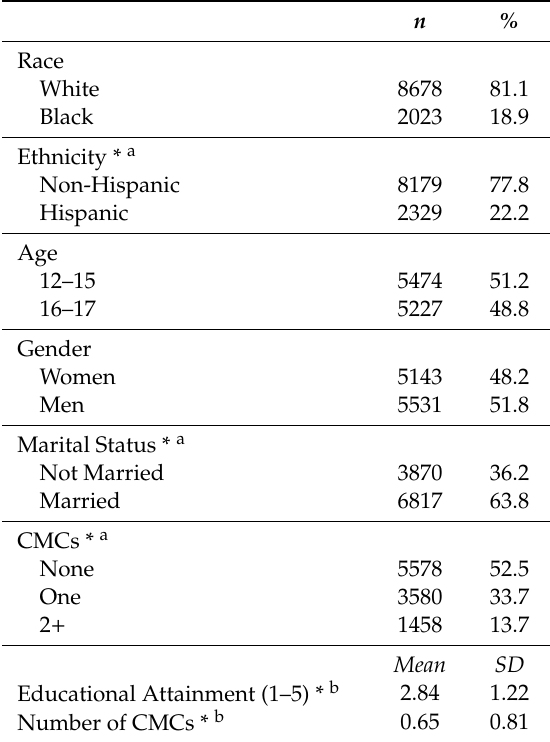
Table 1. Descriptive statistics in the overall